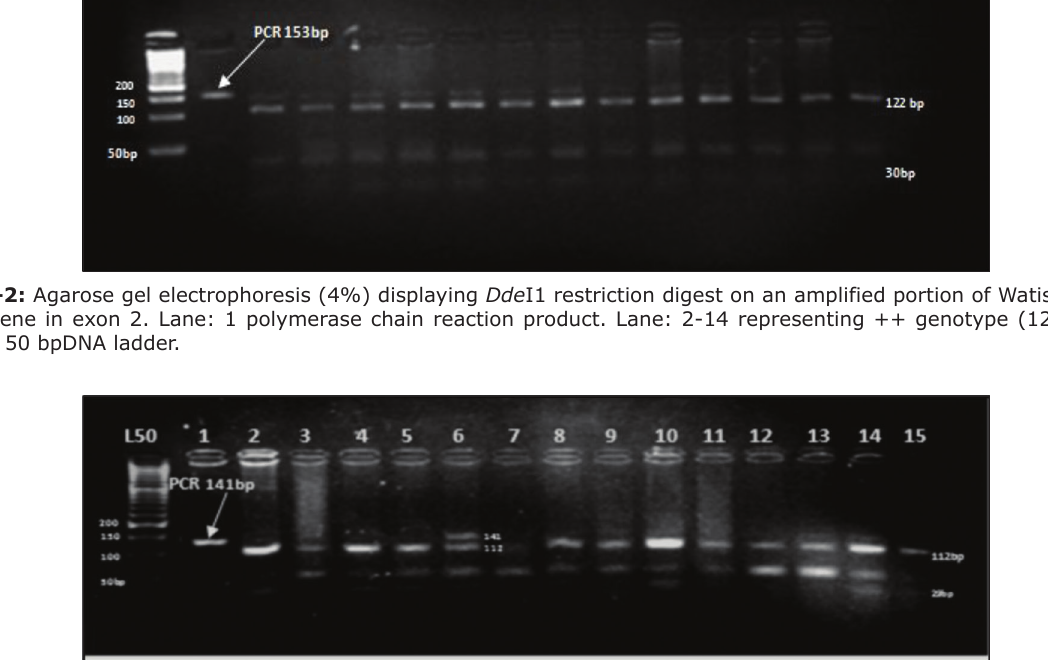
Figure-3: Agarose gel electrophoresis (4%) displaying Hinf I/digest an amplified portion of exon2 of the Watish BMP15- FecX G gene. Lane 1: Polymerase chain reaction product. Lanes 2-5, 7-15: Represent ++. Lane 6: Represent G+. Lane L: 50 bp DNA